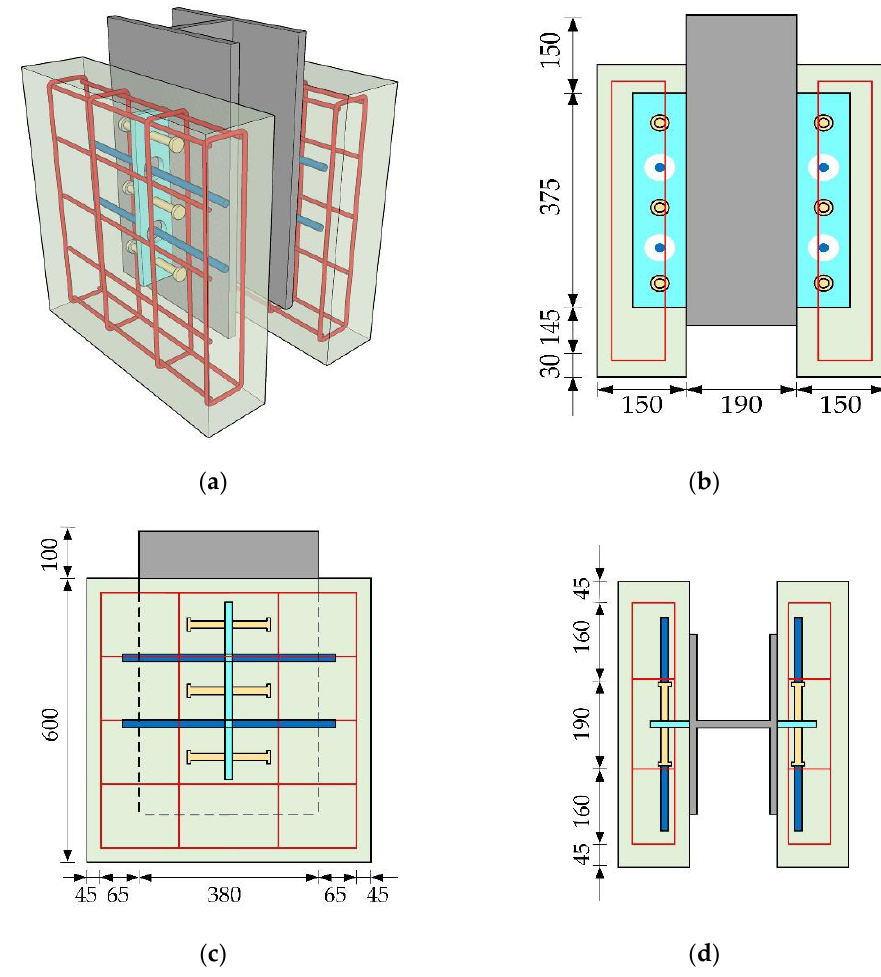
Figure 1. Common dimensions of specimens: ( a ) overall view; ( b ) front view; ( c ) side view; ( d ) top view (unit: mm).